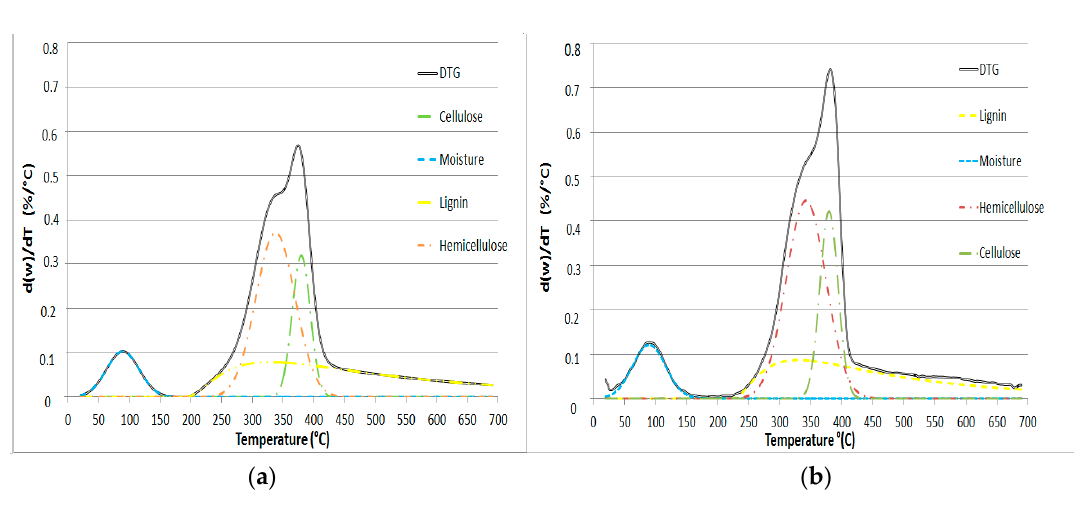
Figure 2. Deconvolution for ( a ) NL-B and ( b ) L-B at a 50 °C/min heating ramp.